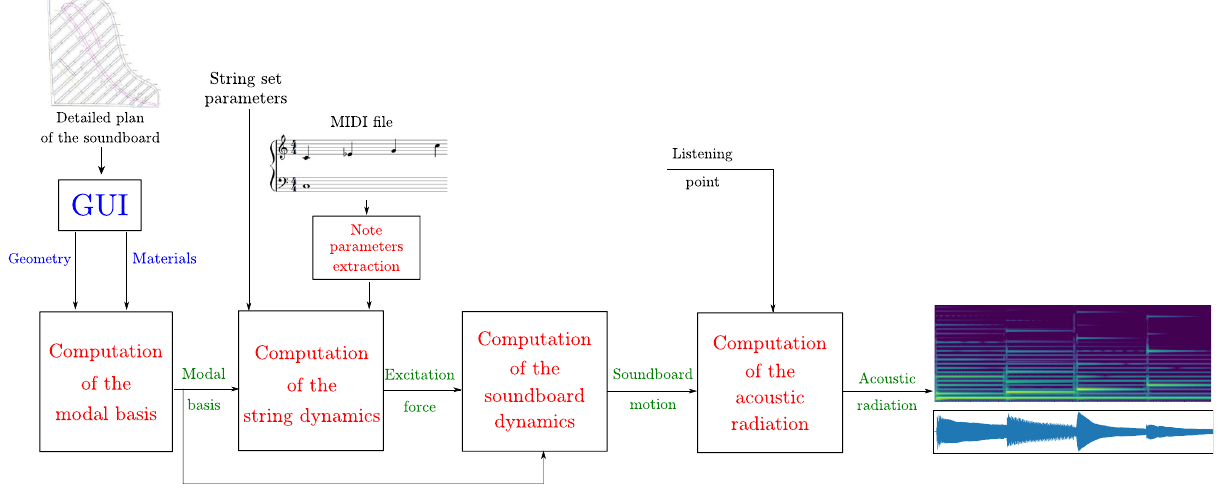
Figure 1. Block-diagram of the software architecture. The input data provided by the user are represented by a black font color. Blue corresponds to user data entered in the GUI. The software operations and the software outputs are represented by the red and green font colors,